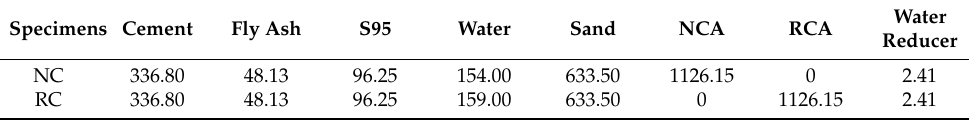
Table 3. Concrete sample mixtures for experiments (kg/m 3